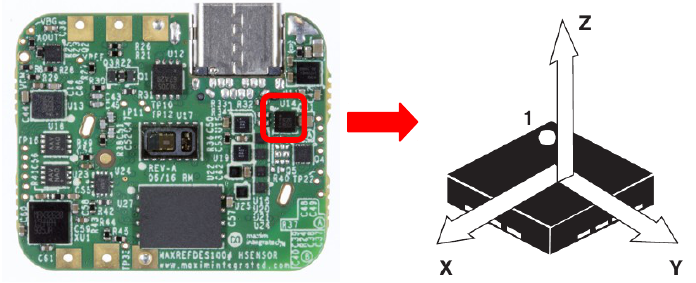
Figure 3. Accelerometer orientation